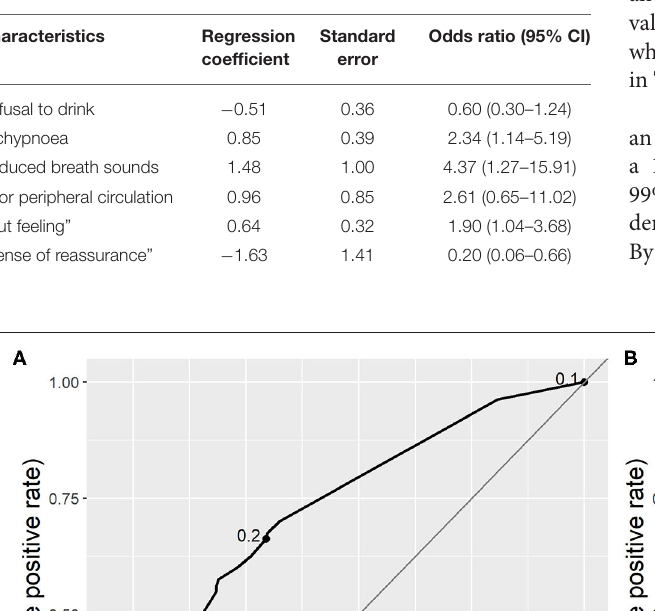
Frontiers in Pediatrics |